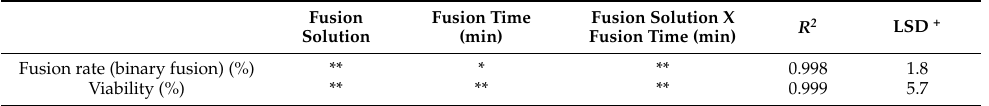
Table 4. ANOVA results for the effect of different fusion solution and fusion time on protoplast fusion frequency (%) between J. sambac.L and J. mesnyi.